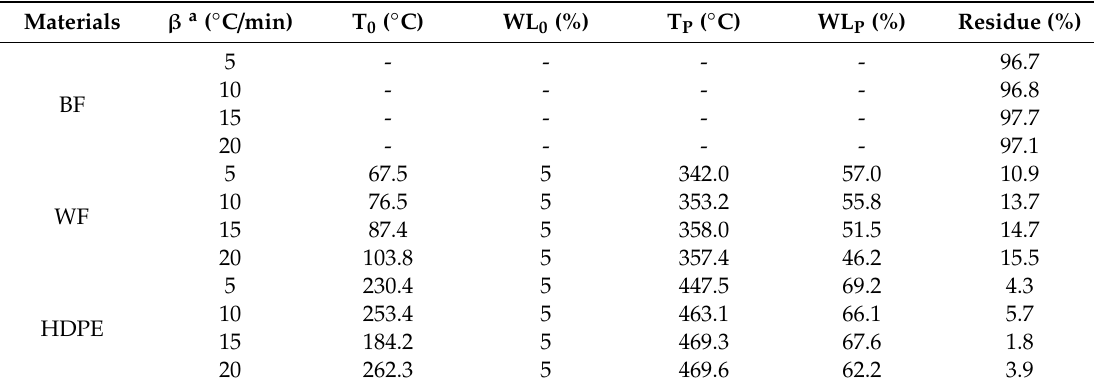
Figure 1. Thermal decomposition process of raw materials at a heating rate of 20 ◦ C / min. BF, basalt fiber; WF, wood flour; HDPE, high density polyethylene. Table 3. Thermal decomposition parameters of raw